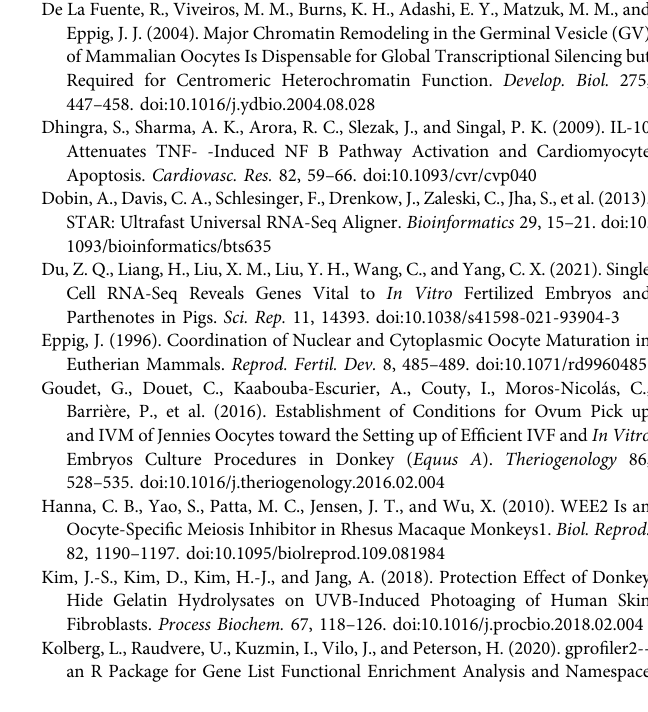
Supplementary Figure S1 | (A) The evaluation of WGCNA genes of oocyte development during GV – MII in different species. Left panel, analysis of the scale-free fi tindexforvarioussoftthresholdingpowers.Thebluelinerepresentsascale-free fi tindex of0.9.Rightpanel,analysisofthemeanconnectivityforvarioussoft-thresholdingpowers. (B) The hierarchical cluster tree shows functional modules distinguished by WGCNA. Bottom part, different colors represent different modules. (C) The heat map plot shows the topological overlap matrix (TOM) among 500 randomly selected genes. Light purple color depict a small overlap, and the red color indicates a greater